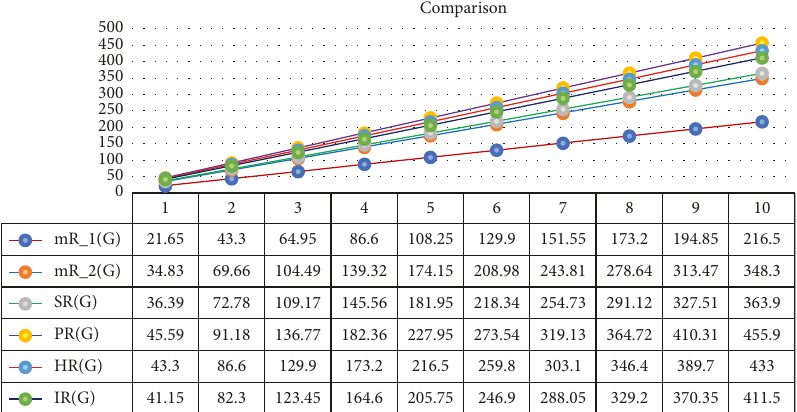
m R 2 ( PF ) , SR ( PF ) , PR ( PF ) ,